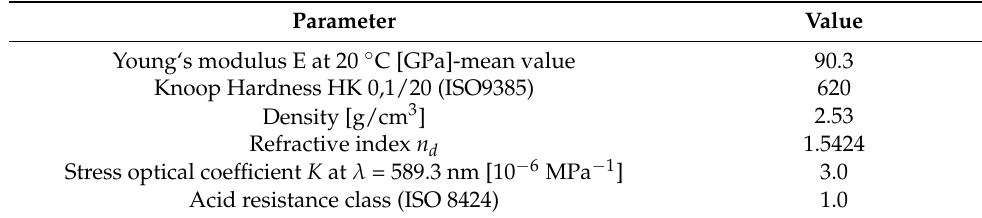
Table 3. Typical mechanical, optical and chemical properties of Zerodur ®